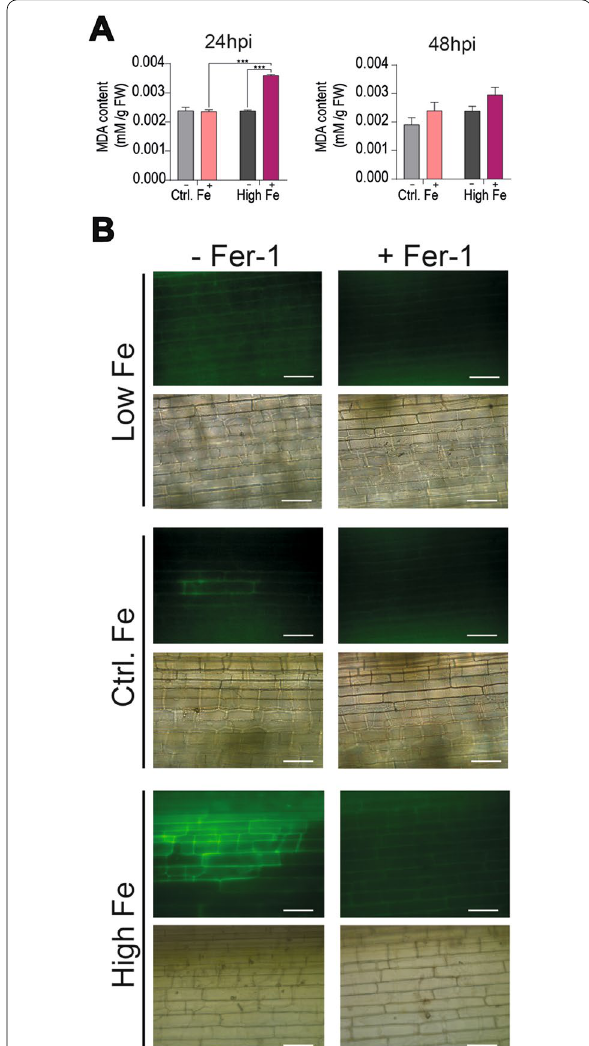
Fig. 10 Lipid peroxidation in leaves of Low‑Fe, Control‑Fe, and High‑Fe rice plants upon infection with M. oryzae . A MDA content in leaves (youngest developed leaves) of mock‑inoculated and M. oryzae ‑inoculated plants ( , mock‑inoculated; , inoculated with − + M. oryzae spores). B Confocal microscopy was performed on M. oryzae ‑infected leaves (48 hpi) treated, or not, with the ferroptosis inhibitor Fer‑1, and stained with C11‑BODIPY 581/591 to monitor oxidized lipid peroxides. Lower panels show the corresponding bright field images. Representative results from two independent experiments are shown. Ap, Appressorium. Bars correspond to 50